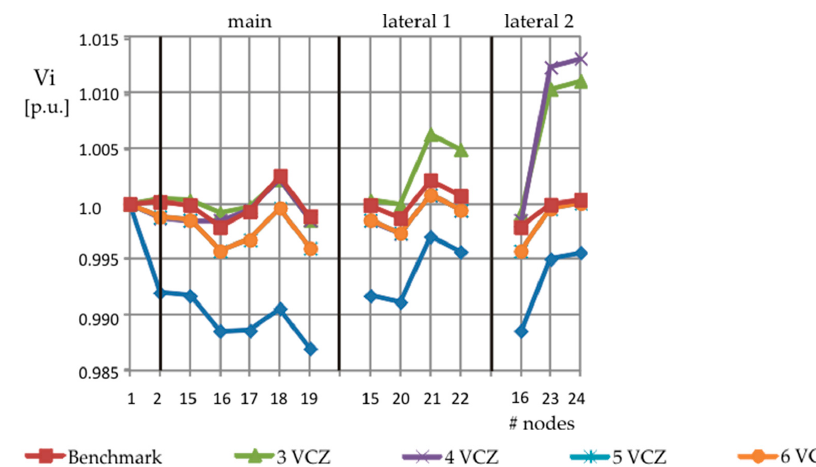
Figure 10 : Voltage profiles for Case R — DG and BESS : P algorithm—feeder 2.